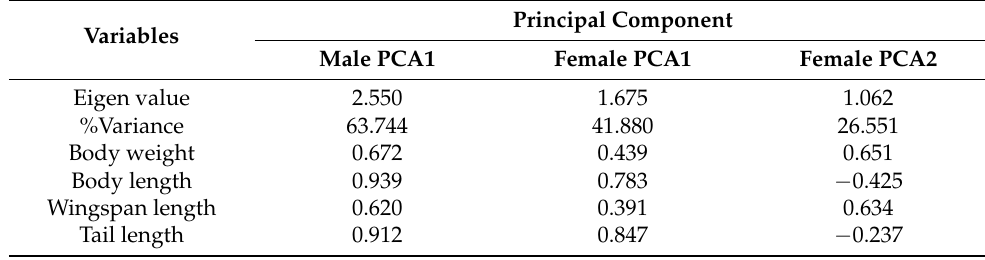
Table A3. Principal component analysis of morphologic characteristics of male and female Reeves’s